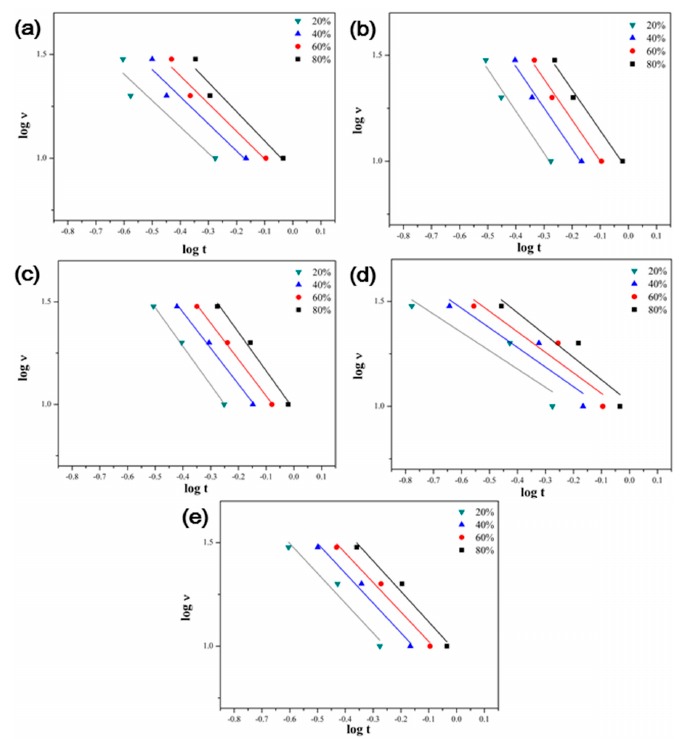
Figure 11. Plots of log v versus log t of the PPS/MWCNTs composites at different relative crystallinity. ( a ) Neat PPS, ( b ) PPSP1, ( c ) PPSA1, ( d ) PPSHP1, and ( e ) PPSS1.